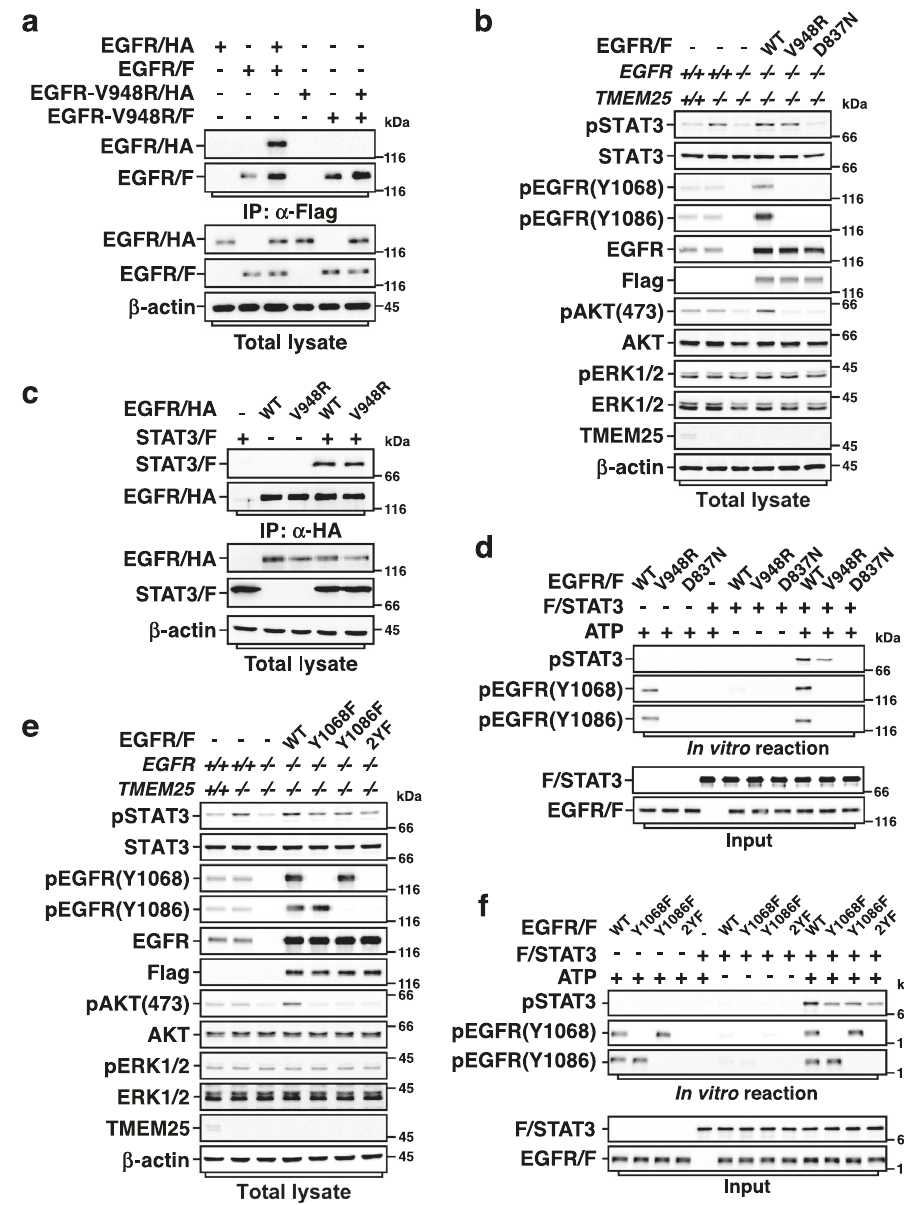
Fig. 5 | Monomeric EGFR is able to phosphorylate STAT3 in the absence of TMEM25. a EGFR-V948R mutant does not form dimer. HEK293T cells trans- fected with indicated combinations of EGFR/HA, EGFR/F, EGFR-V948R/HA, or EGFR-V948R/F were subjected to Co-IP assay. b EGFR-V948R is able to phosphorylate STAT3. Lentivirus encoding Flag-tagged wild-type (WT) EGFR, EGFR-V948R, or EGFR-D837N were transduced into TMEM25 and EGFR double knockout ( TMEM25 − / − EGFR − / − ) MDA-MB-231 cells as indicated. The cells were serum starved overnight and then subjected to immunoblotting assay. c EGFR-V948R binds STAT3. HEK293T cells transfected with indicated com- binations of STAT3/F and EGFR/HA (WT or V948R) were subjected to Co-IP assay. d EGFR-V948R can directly phosphorylate STAT3 in vitro. Exogenously expressed EGFR/F (WT, V948R, or D837N) in EGFR − / − MDA-MB-231 cells were serum starved overnight and then af fi nity puri fi ed for subjecting to in vitro